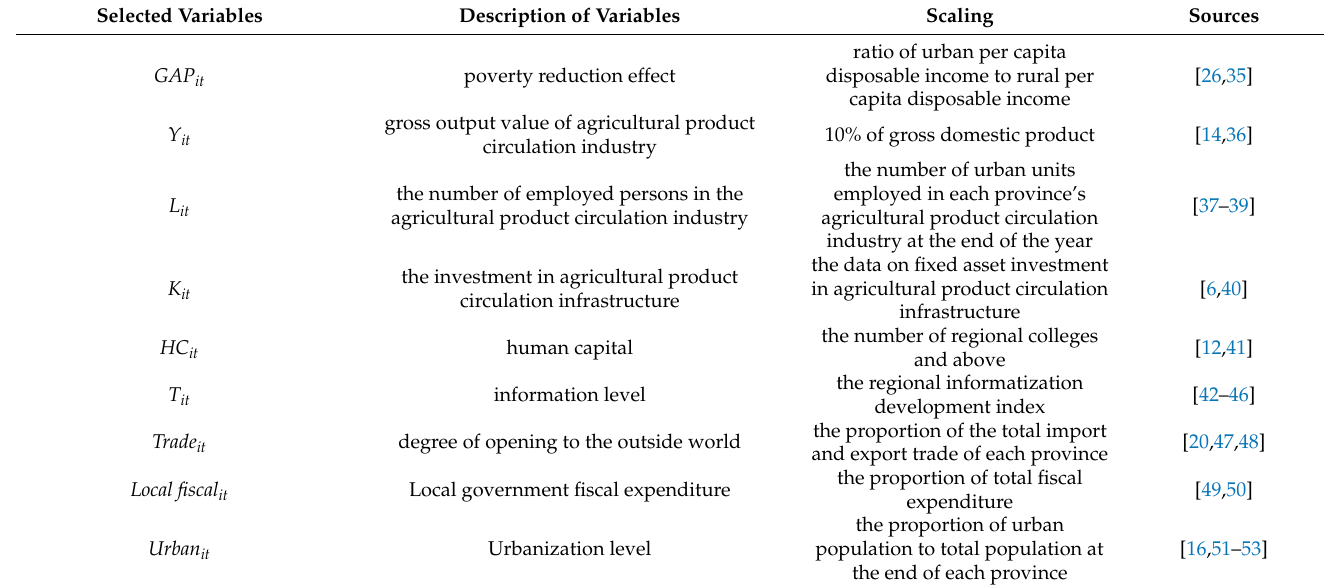
Table 1. Description of selected variables and sources for assessing poverty